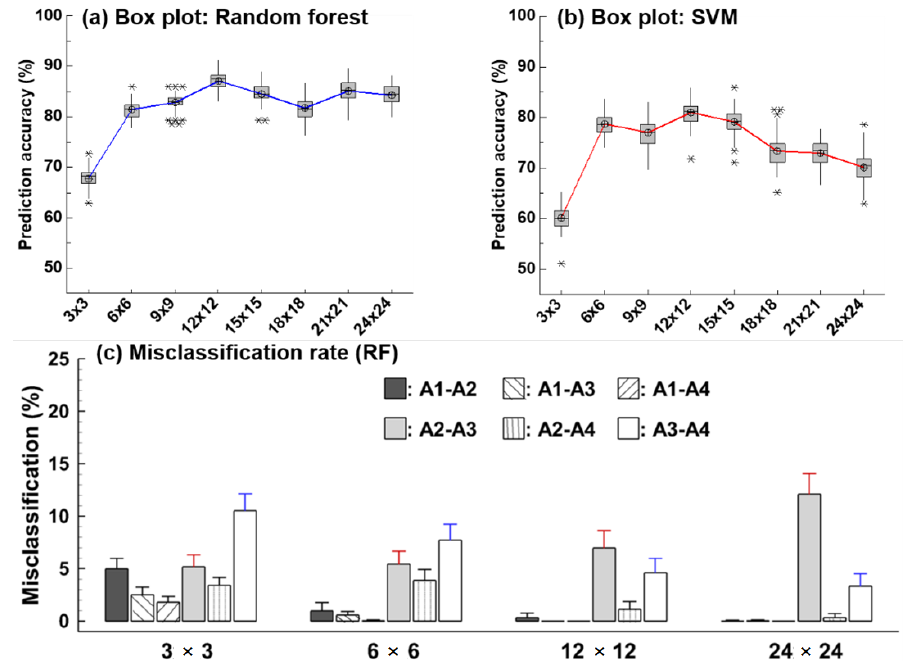
Figure 14. Image classification in the test case 3: ( a ) the predicted five-class classification accuracies based on RF at different sampling resolutions, ( b ) those based on SVM, and ( c ) the misclassification rate based on RF. The asterisks in ( a ) and ( b ) are outliers.